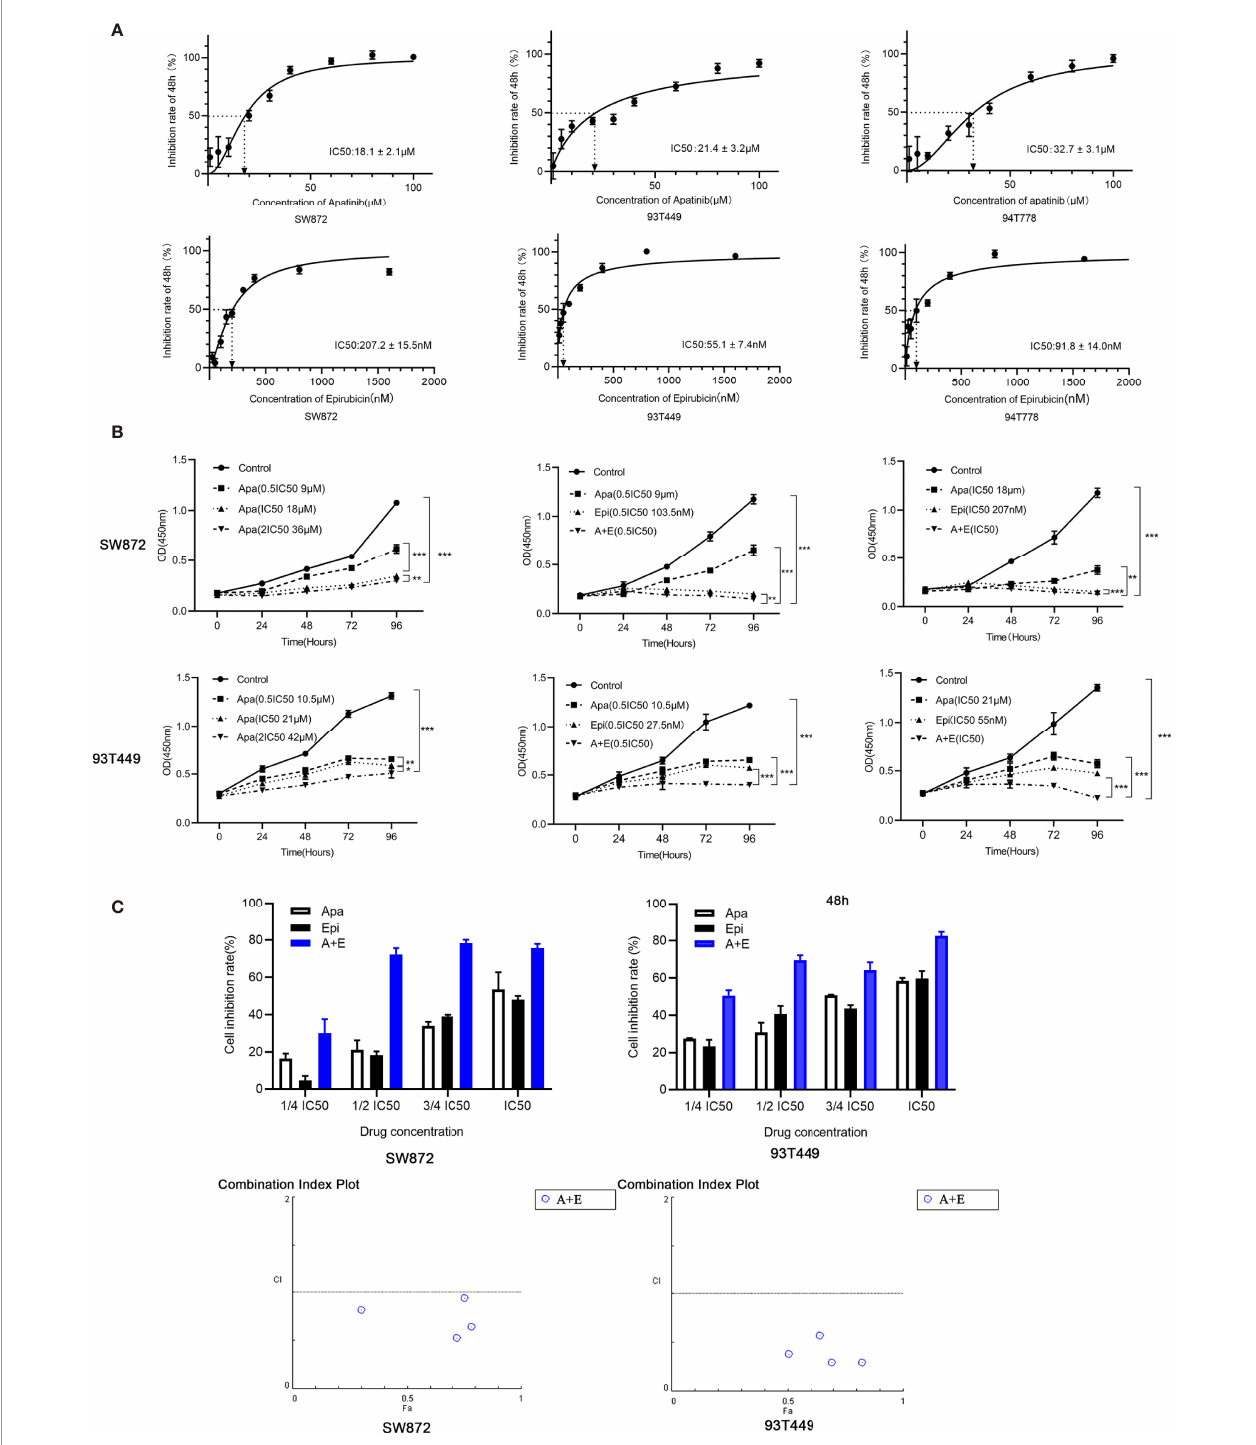
FIGURE 2 | Apatinib and its combination with Epirubicin inhibited proliferation of RLPS cells. (A) CCK-8 assay revealed that the IC50 of Apatinib were 18.1 ± 2.1 m M for SW872 cells, 21.4 ± 3.2 m M for 93T449 cells, and 32.7 ± 3.1 m M for 94T778 cells and the IC50 of Epirubcin were 207.2 ± 15.5 nM for SW872 cells, 55.1 ± 7.4 nM for 93T449 cells, and 91.8± 14.0 nM for 94T778 cells. (B) Apatinib alone and its combination with Epirubicin inhibited RLPS cell proliferation. (C) Combination of Apatinib and Epirubicin synergistically inhibited liposarcoma proliferation. Fa: fractional activity (ef fi cacy); CI: combination index; (*P < 0.05, **P < 0.01, ***P <